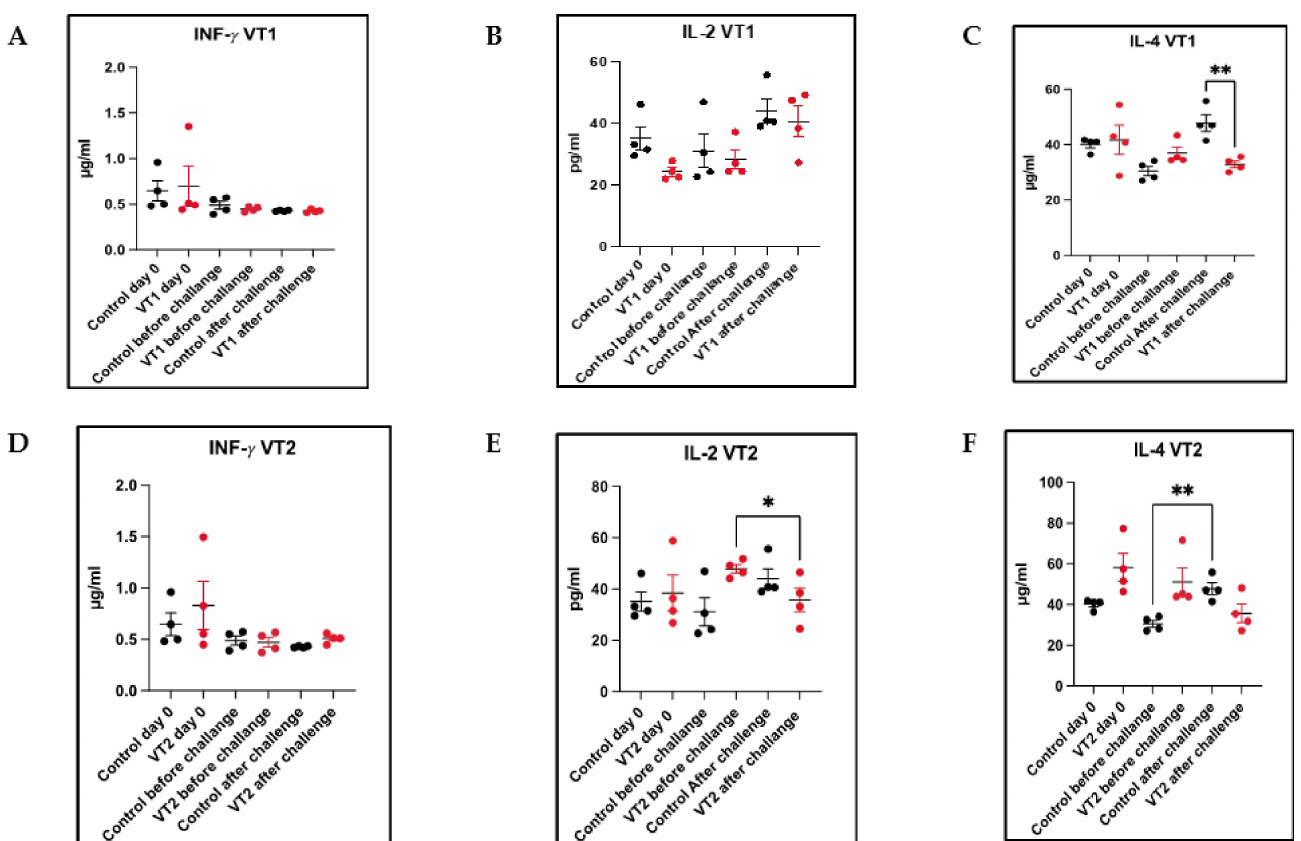
Figure 9. ( A – F ) Cellular immune responses in VT1- and VT2-immunized rabbits following inocu- lation of 50 µ g and 100 µ g of antigen/animal, respectively. The INF- γ ( A , D ), IL-2 ( B , E ), and IL-4 ( C , F ) responses to VT1 and VT2 antigens at different time intervals in immunized and control rabbits. Significant at * p < 0.05; ** p <